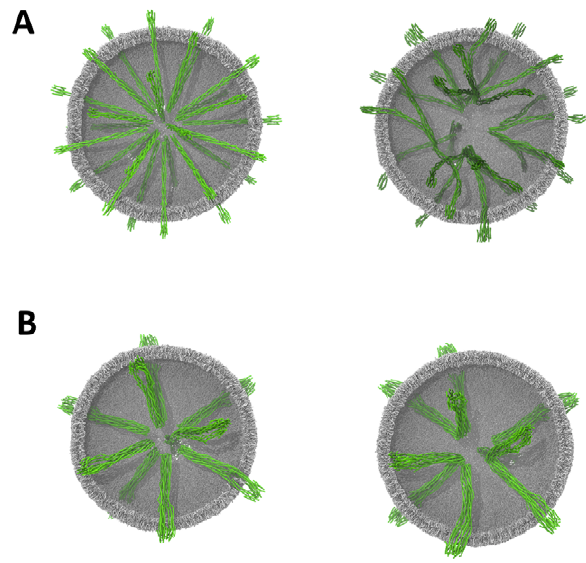
Figure 5. Simulations of multiple Tsr dimer models in a biologically realistic membrane in the form of , 70 nm diameter lipid vesicles. Helices are rendered as green curved tubes, lipids are in grey. A Tsr dimers at t=0 and 1.5 m s, and B Tsr trimer-of- dimers at t=0 and 1 m s. The Tsr dimers can be observed to make a wide variety of interdimer contacts, whereas the trimers-of-dimers form only limited interactions with one another.